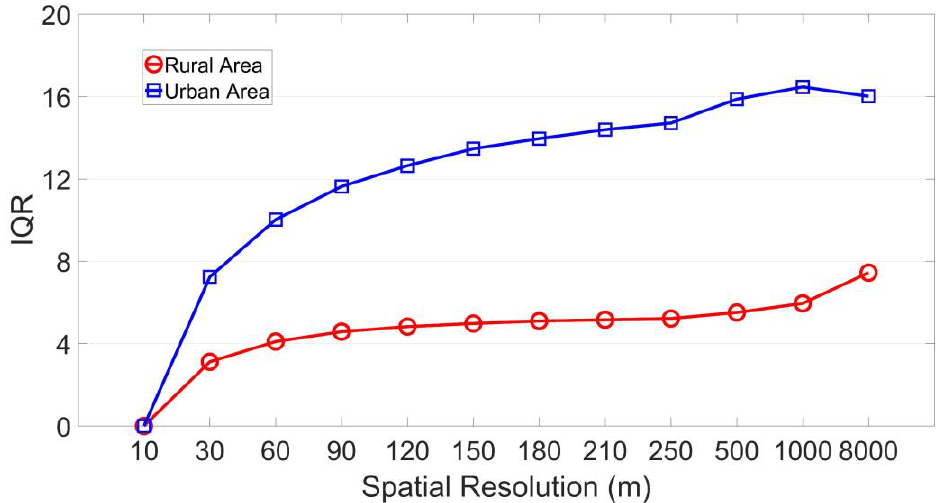
Figure 11. Average IQR at different spatial resolutions in rural and urban areas.